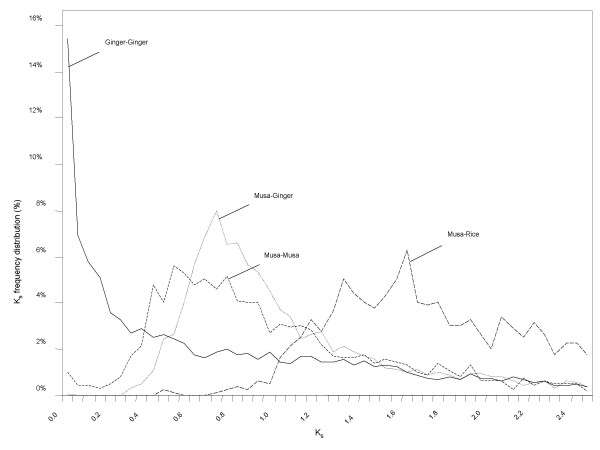
Frequency of synonymous substitution (Ks) in different pairwise species comparisons. These results reveal the existence of whole genome duplications within Musa and revealed an extensive event pre-dating the ginger-Musa or rice-Musa divergences.